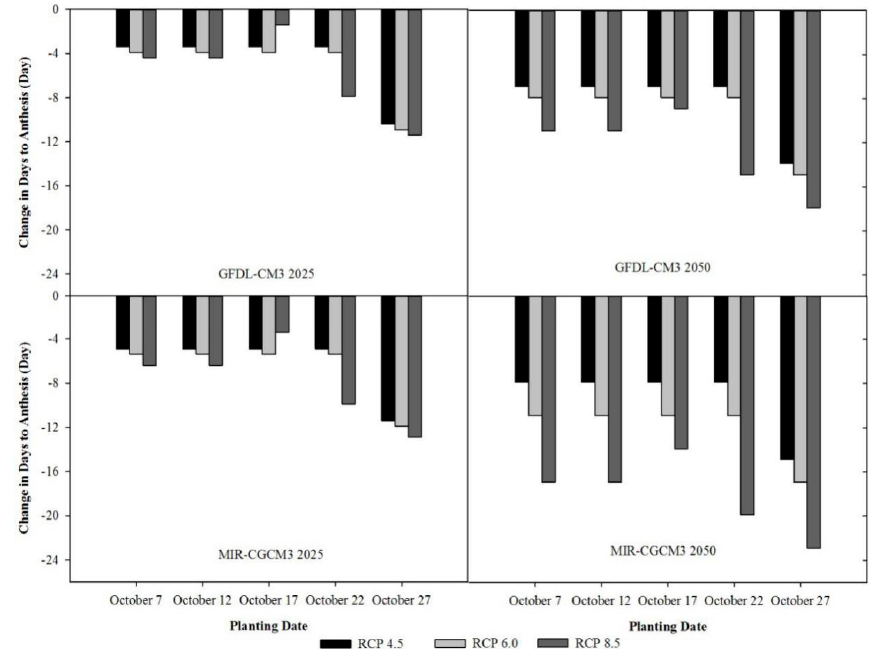
Figure 5. Simulated ADAPS of winter wheat for Guanzhong Plain based on three RCPs under different planting dates based on two GCMs in the 2025 and 2050 projections.